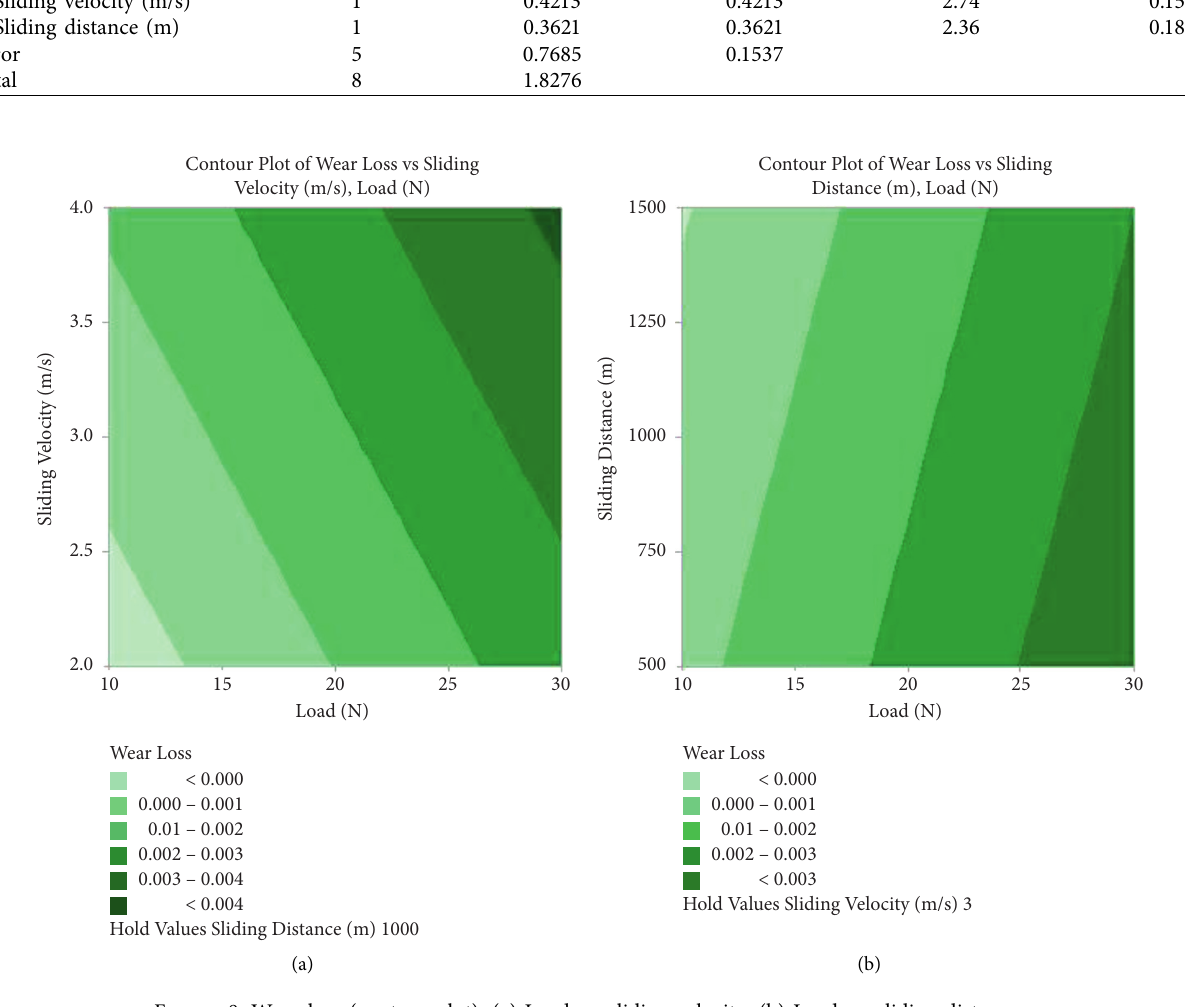
Figure 8: Wear loss (contour plot). (a) Load vs. sliding velocity. (b) Load vs. sliding distance.